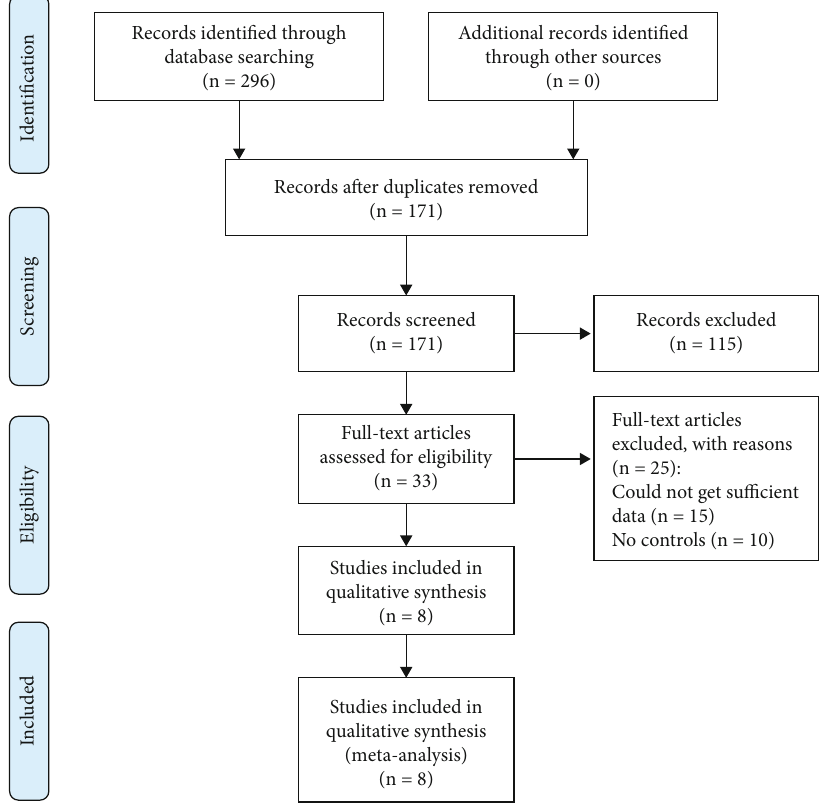
Figure 1: Flow diagram of the literature search. Table 1: Characteristics of the 8 studies in the